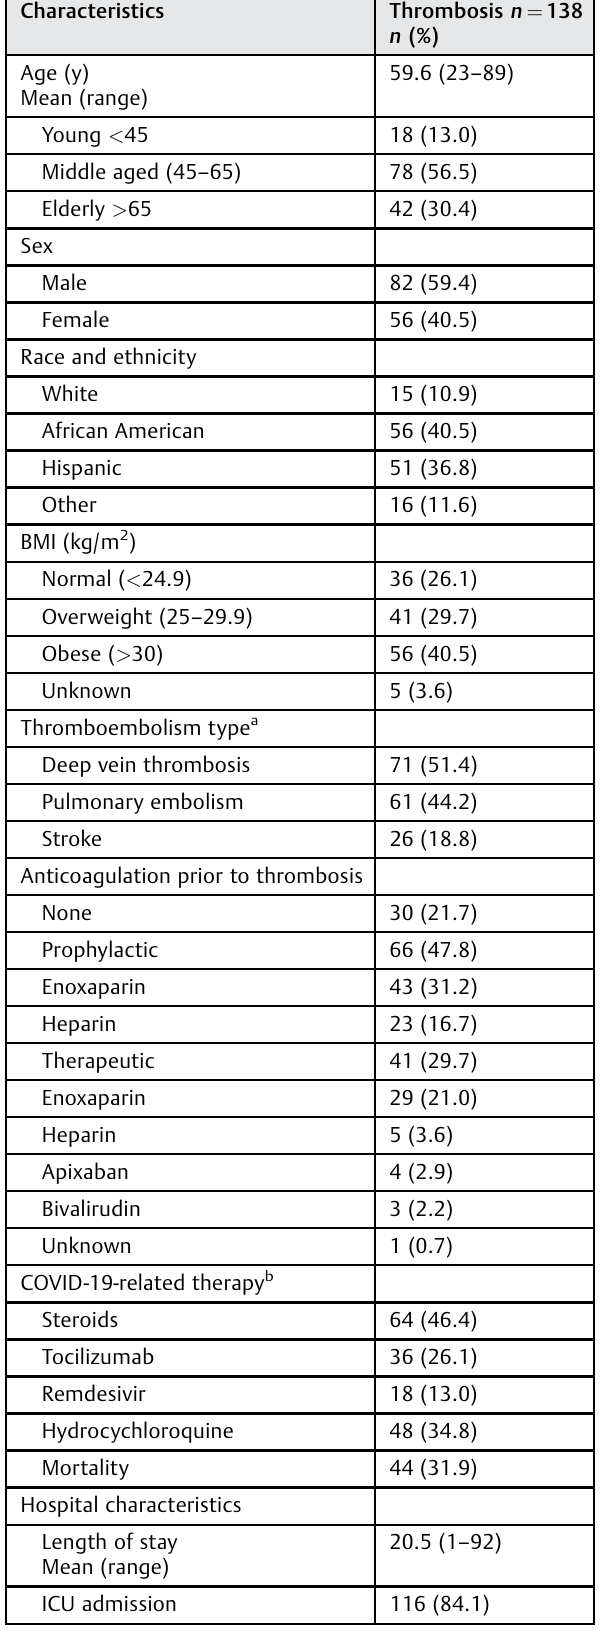
Table 1 Patient characteristics of COVID-19 patients with thrombosis